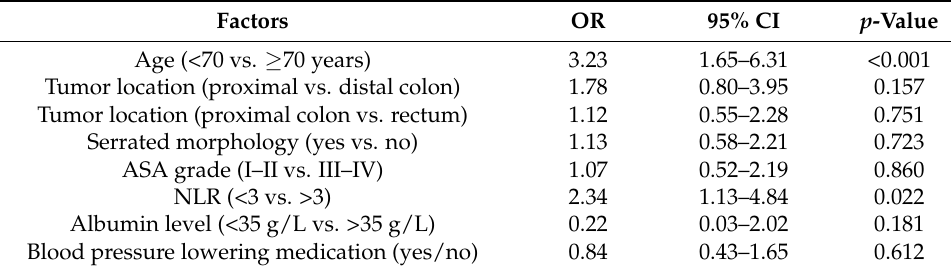
Table 5. Multivariable binary regression model for sarcopenia